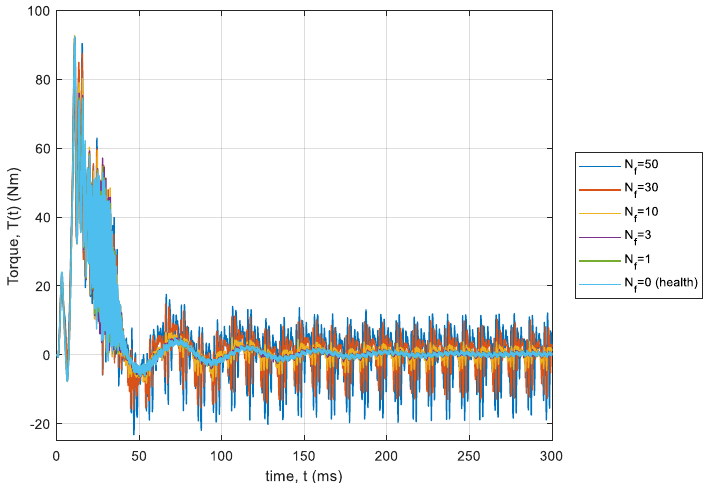
Figure 5. Torque waveforms of a faulty (N f = 1–50) as well healthy (N f = 0) motor without external torque (T L = 0 Nm).